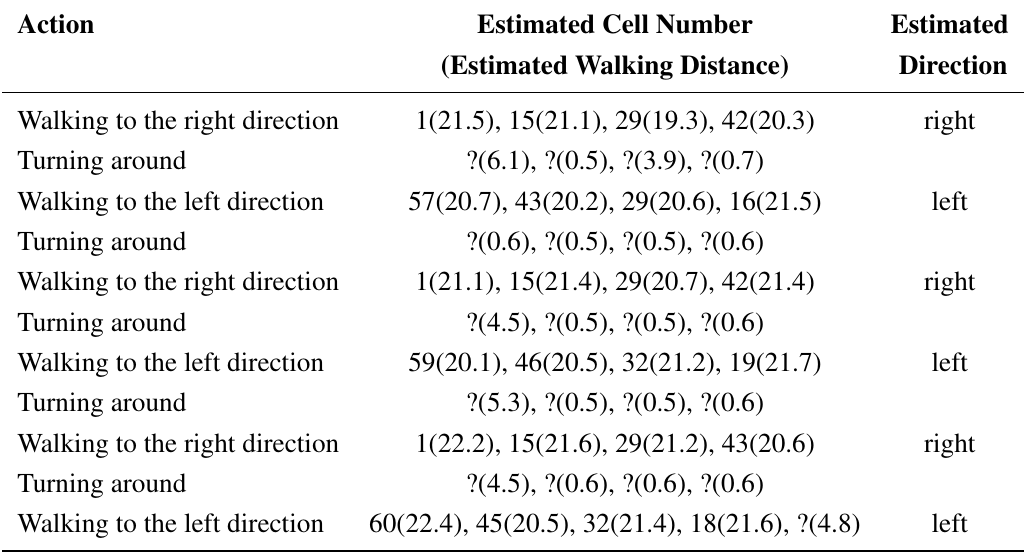
Table 4. Long walking test: three round trips between cell 1 and cell 60 (‘?’ symbol means the segment is too short for the location estimation).